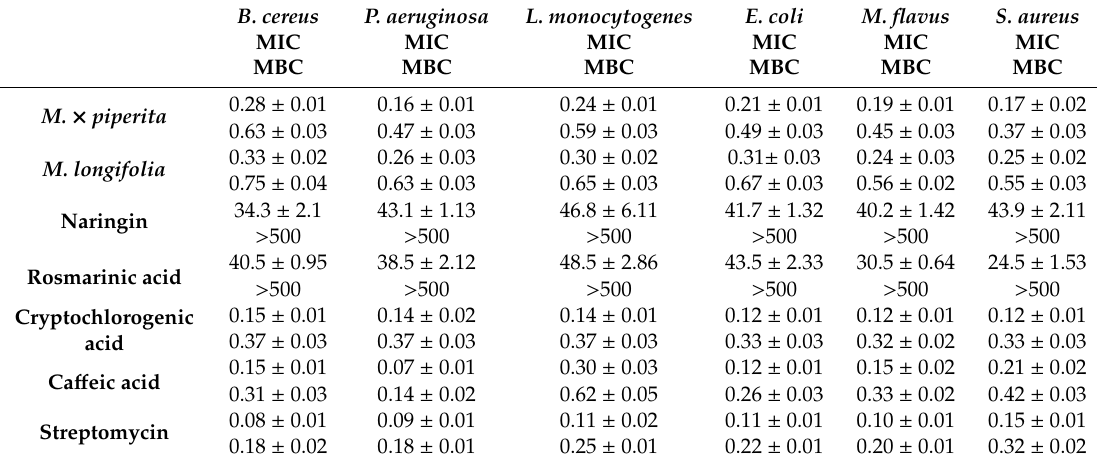
Table 4. The antibacterial activities of M. × piperita and M. longifolia leaf extracts, naringin, and rosmarinic, cryptochlorogenic, and ca ff eic acids, presented as the mean ± SD ( µ g / mL) of the minimum inhibitory concentration (MIC) and minimum bactericidal concentration (MBC).